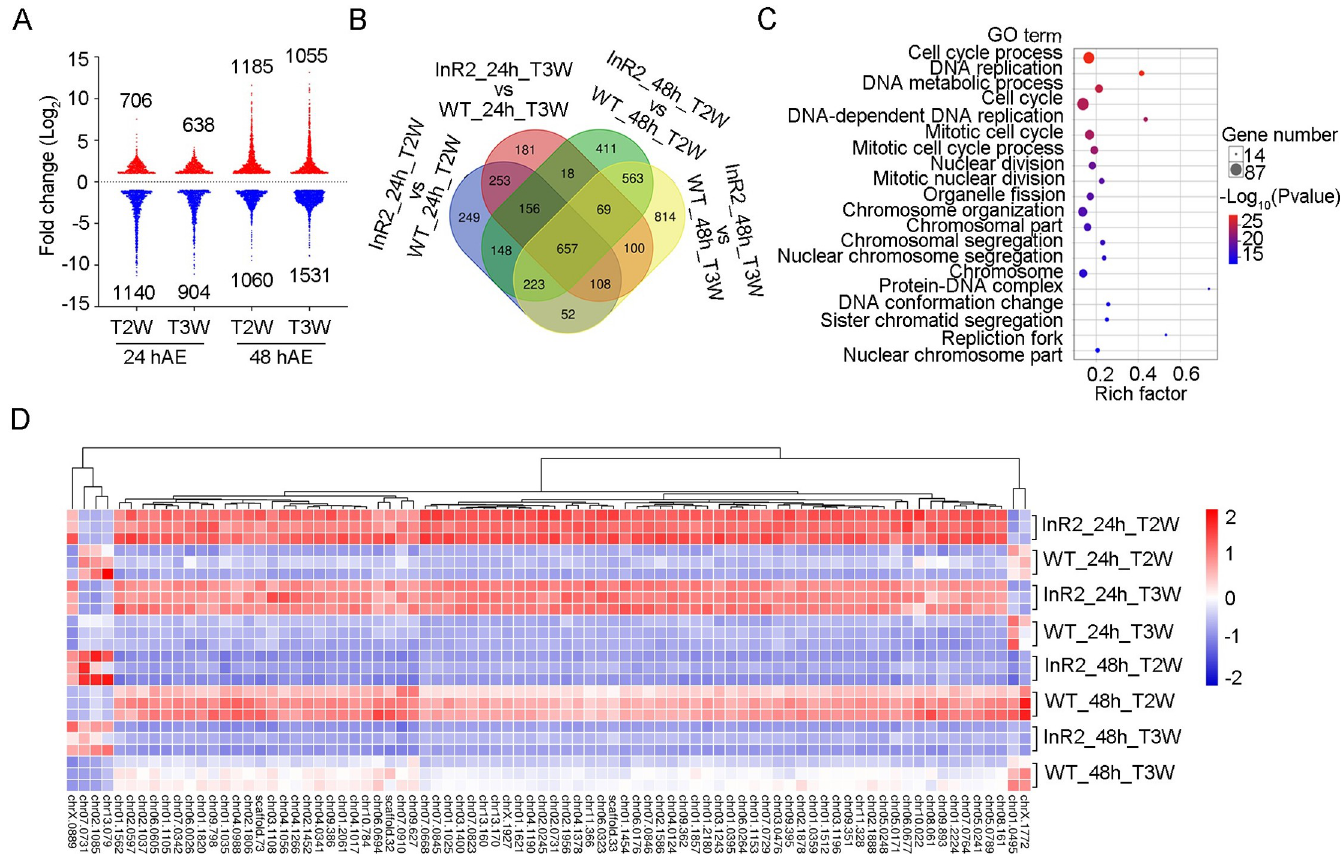
Fig 5. Comparative transcriptomic analysis of wing buds from 5 th -intar NlInR2 E4 and Wt SW nymphs. (A) Differentially expressed genes (DEGs) in wing buds from 5 th -instar NlInR2 E4 and Wt SW nymphs. Numbers of up-regulated and down-regulated genes are indicated. T2W and T3W represent wing buds on the second and third thoracic segment, respectively. DEGs were screened based on the criteria of fold-change � 2 and adjusted P (padj) < 0.01. 24 and 48 hAE indicate 5 th -instar nymphs at 24 and 48 h after ecdysis, respectively. (B) Venn diagram of common/specific DEGs in wing buds of 5 th -instar NlInR2 E4 and Wt SW nymphs. A total of 657 DEGs were commonly regulated by T2W and T3W of 5 th -instar NlInR2 E4 and Wt SW nymphs at 24 and 48 hAE. (C) The top 20 enriched Gene Ontology (GO) terms of commonly regulated DEGs (657) in wing buds of NlInR2 E4 and Wt SW nymphs. The GO term of ‘cell cycle process’ (GO: 0022402) was the most significantly enriched. (D) Heat- map of DEGs in the GO term of ‘cell cycle process’ (GO: 0022402). Up-regulated and down-regulated genes are indicated in red and blue, respectively. Expression level indicated by log2FoldChang. InR2_24h_T2W and WT_24h_T2W: T2W from 24h-5 th -instar NlInR2 E4 and Wt SW nymphs, respectively. InR2_24h_T3W